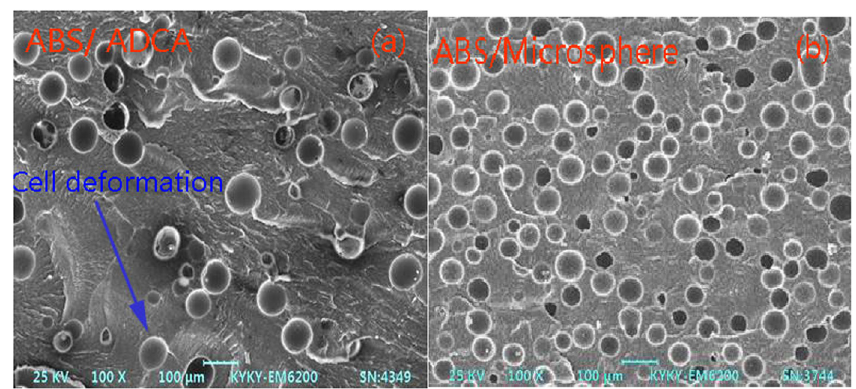
Figure 6: Cell structure of foamed ABS material under injection molding.